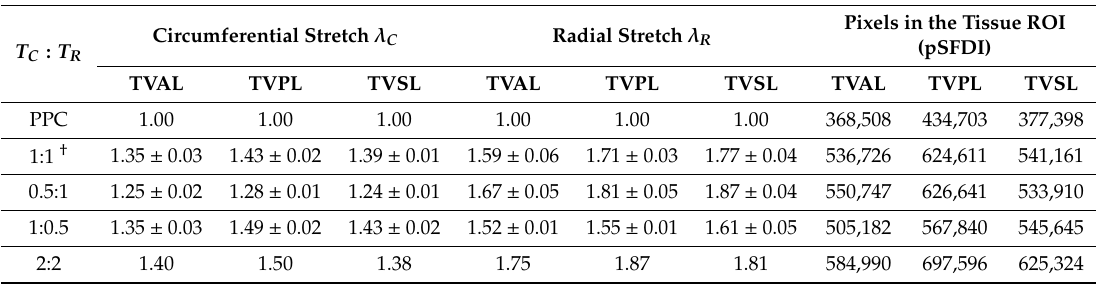
† Note that the targeted membrane tension is 25 N / m with respect to the equibiaxial loading protocol, i.e., T (25 N / m): (25 N /